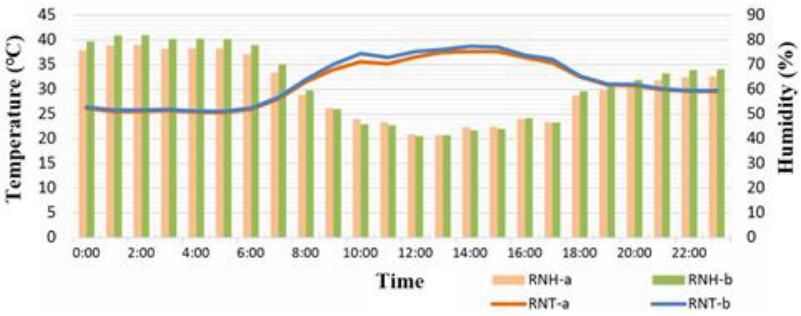
Figure 4. Comparison of RNH and RNT between a and b. Table 7. Region B: Data collected on the reduction in temperature under solar panel shade.